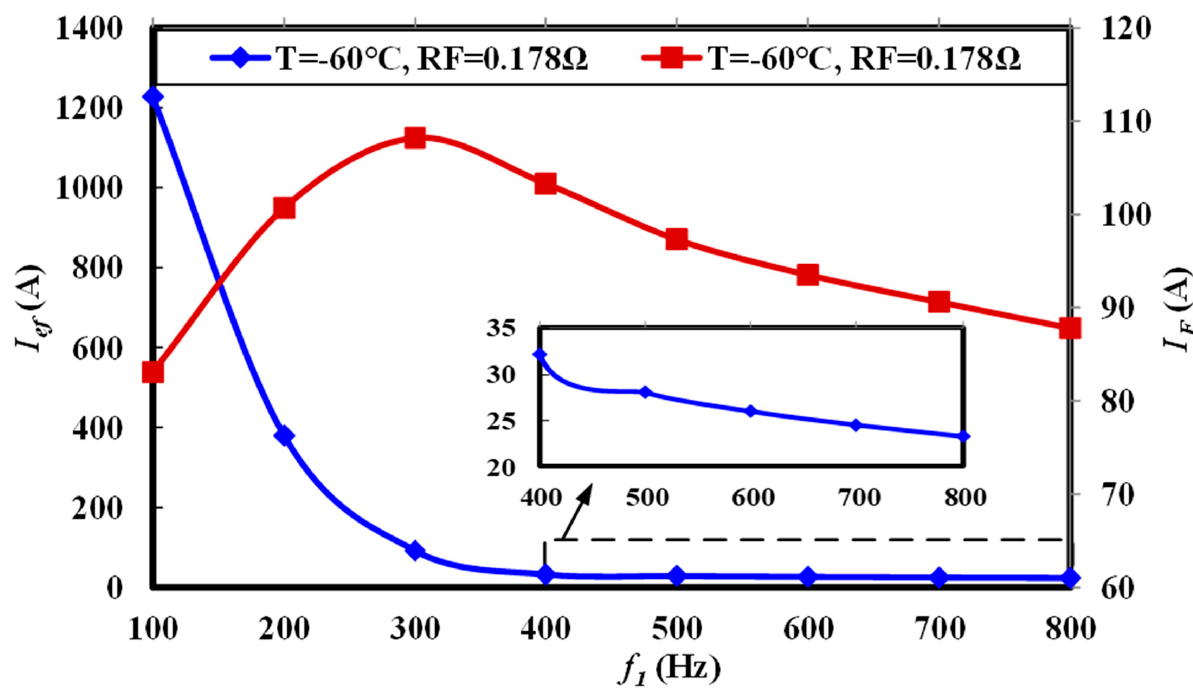
Figure 9. The curve of exciting current I ef and I F changing with exciting frequency f 1 .